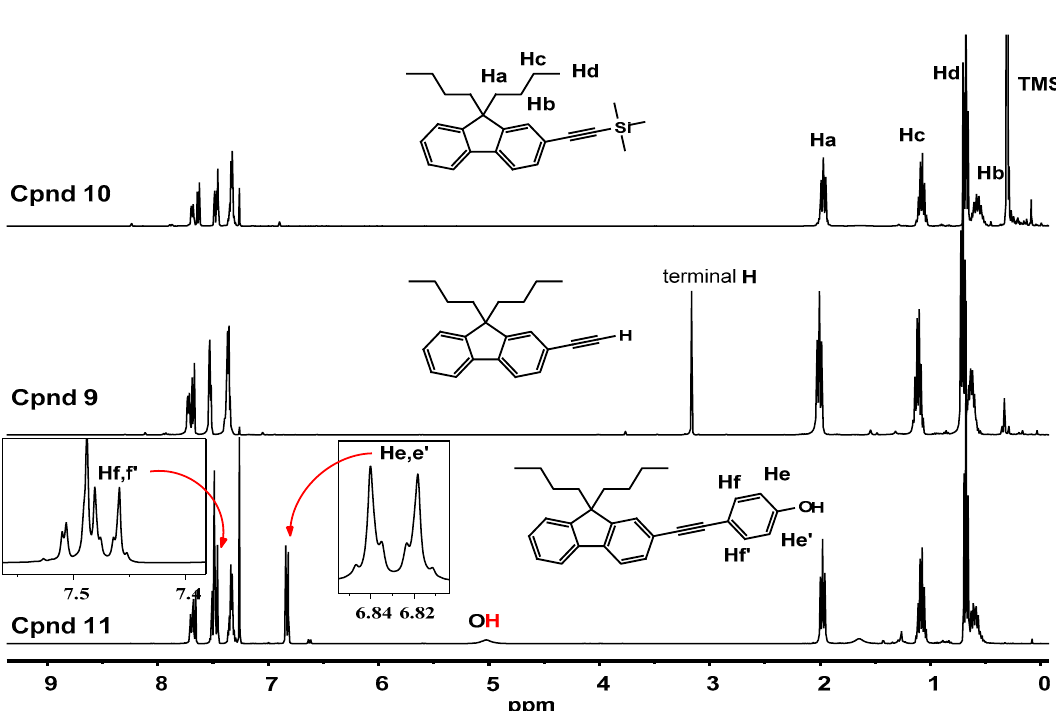
Figure 4. 1 H-NMR spectra of the fluorene-containing precursors 10 , 9 , and 11 in CDCl 3 .